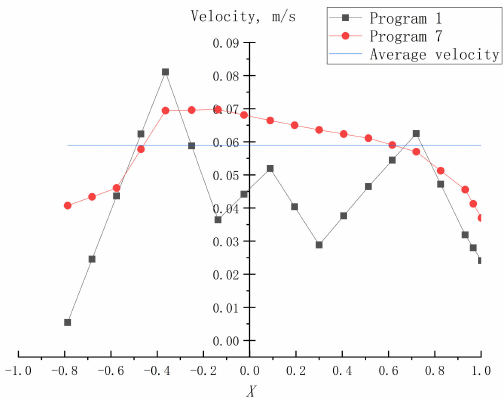
Figure 25. Plan 1 and 7 velocity at point b, section